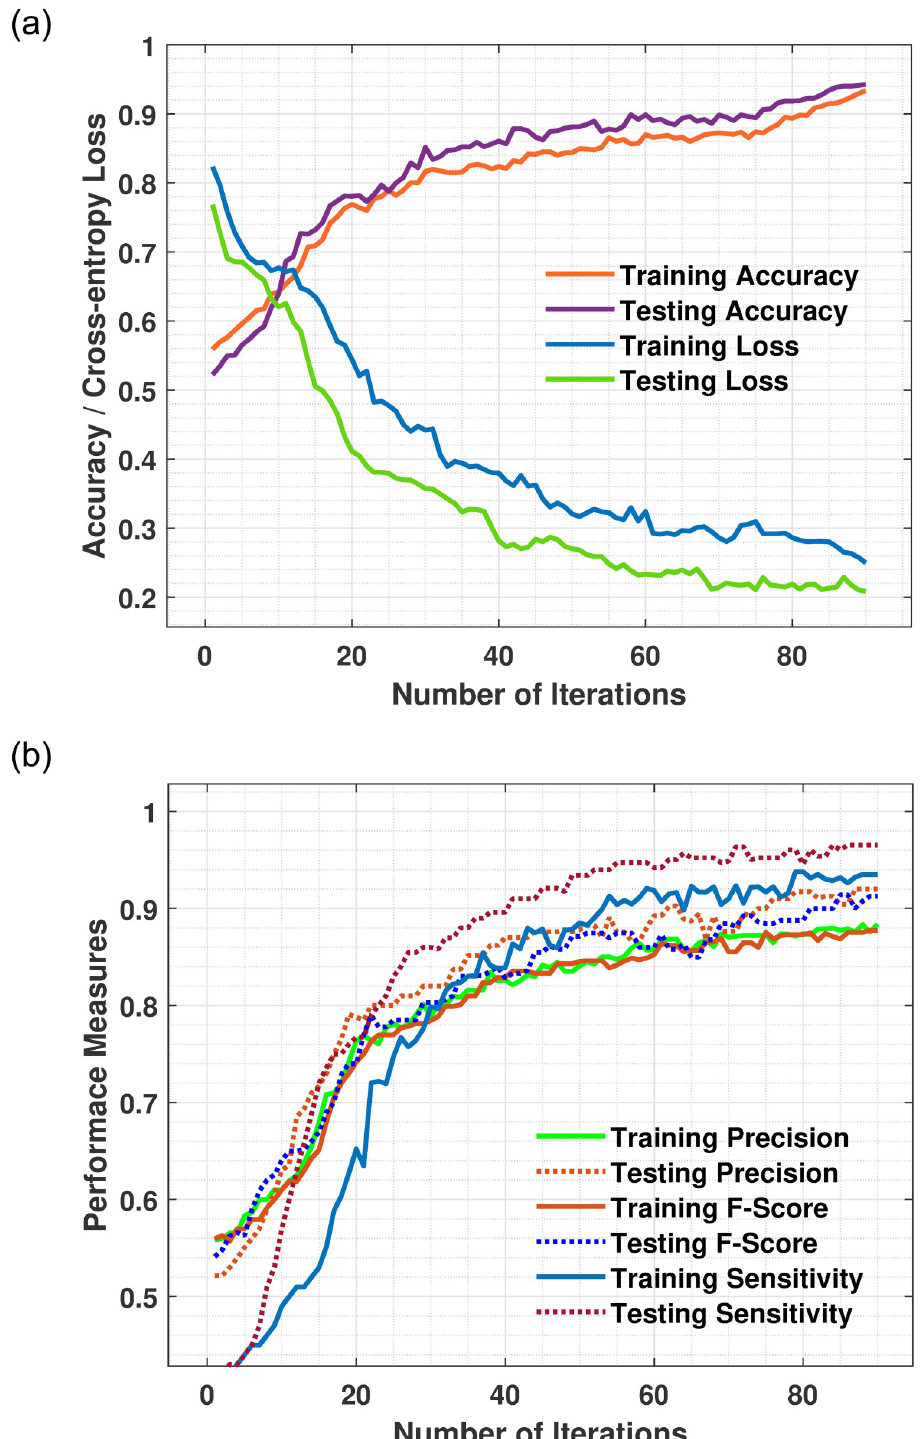
Fig 6. (a) Depicts the suggested system’s accuracy and cross-entropy loss throughout the training phase. The ascending curves indicate the proposed system’s accuracy, while the descending curves indicate the proposed system’s loss value on the training and testing MIAS dataset. The training and testing curves are nearly identical, suggesting that the model was appropriately trained. (b) Training and testing precision, F-score and sensitivity of proposed model using MIAS